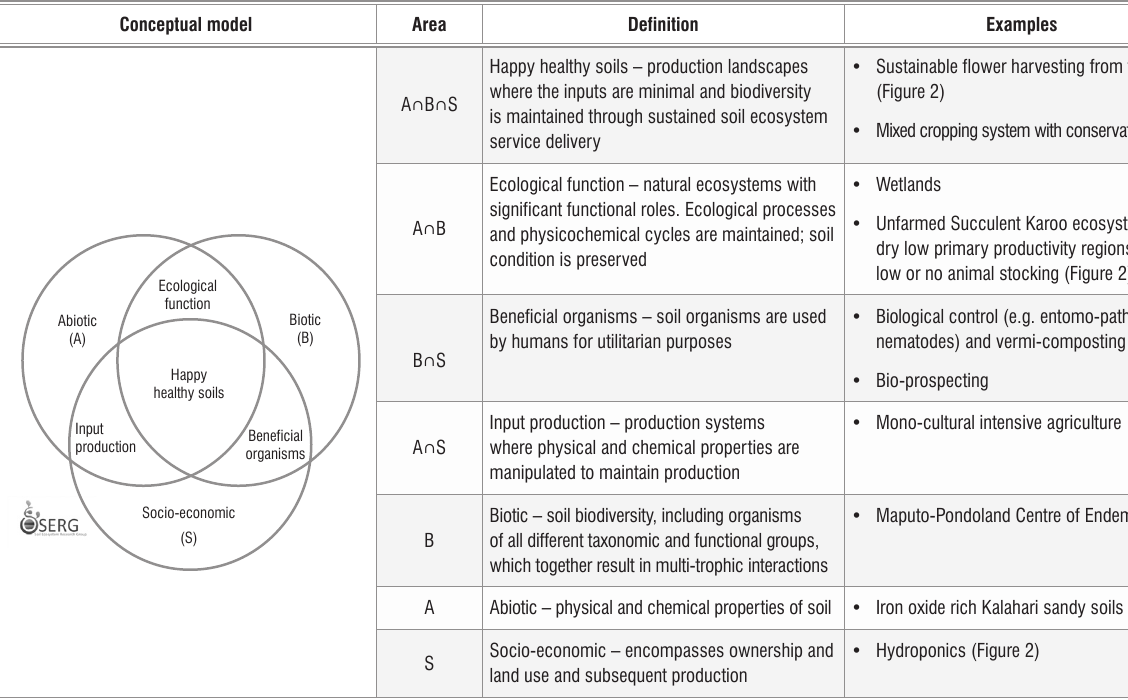
Figure 1: Proposed conceptual scheme for defining soil. We consider healthy soils as those that provide abiotic, biotic and socio-economic services.